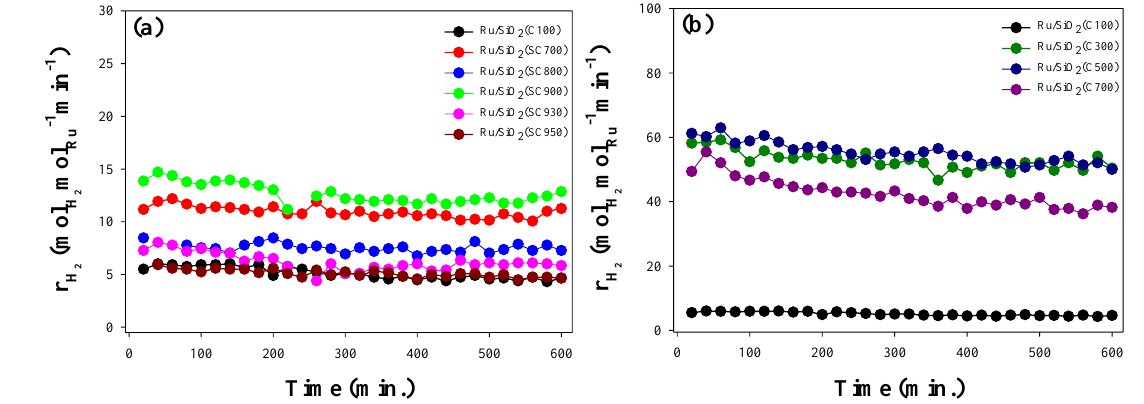
2 formation rates based on the amount of Ru metal were obtained at 400 °C